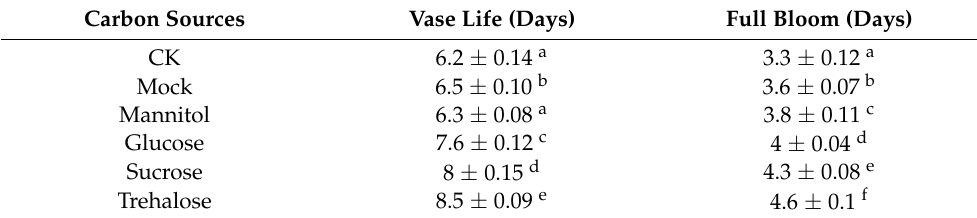
Table 4. Vase life and full bloom days of cut flowers in a fresh-keeping solution containing different carbon sources.